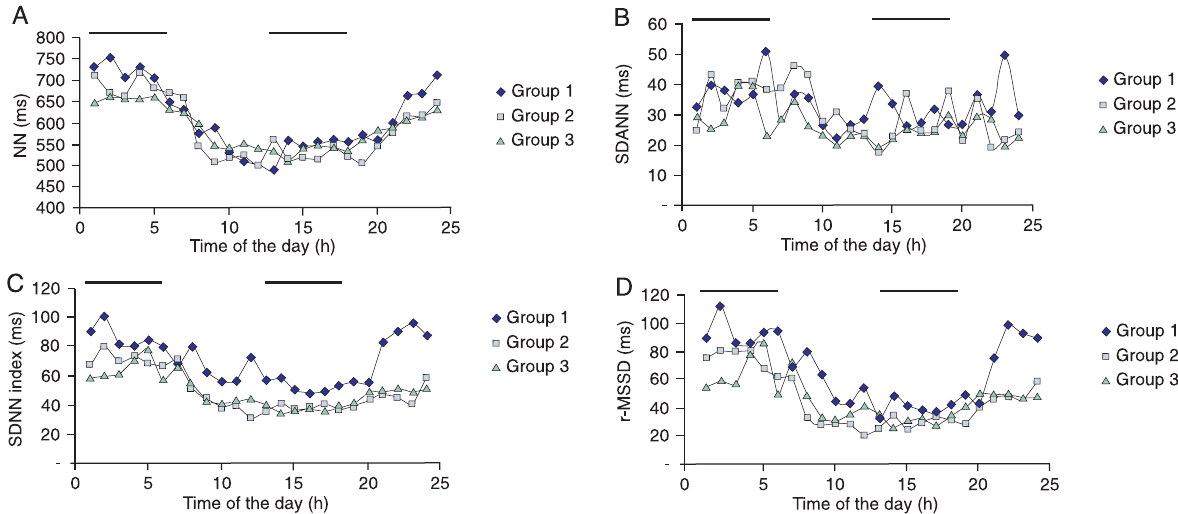
Figure 1. Circadian variation of hourly NN (A), SDANN (B), SDNN index (C), and r-MSSD (D) graphs of group 1 (CD4+ count ≥1000 cells/µL; diamonds), group 2 (CD4+ count <1000 and ≥500 cells/µL; squares), and group 3 (CD4+ count <500 cells/µL; triangles). The horizontal bars on top of the graphs indicate nighttime (1 to 6 am) and daytime (1 to 6 pm) periods. SDANN = hourly standard deviation of the mean of normal RR intervals. See Table 1 for all other abbreviations.